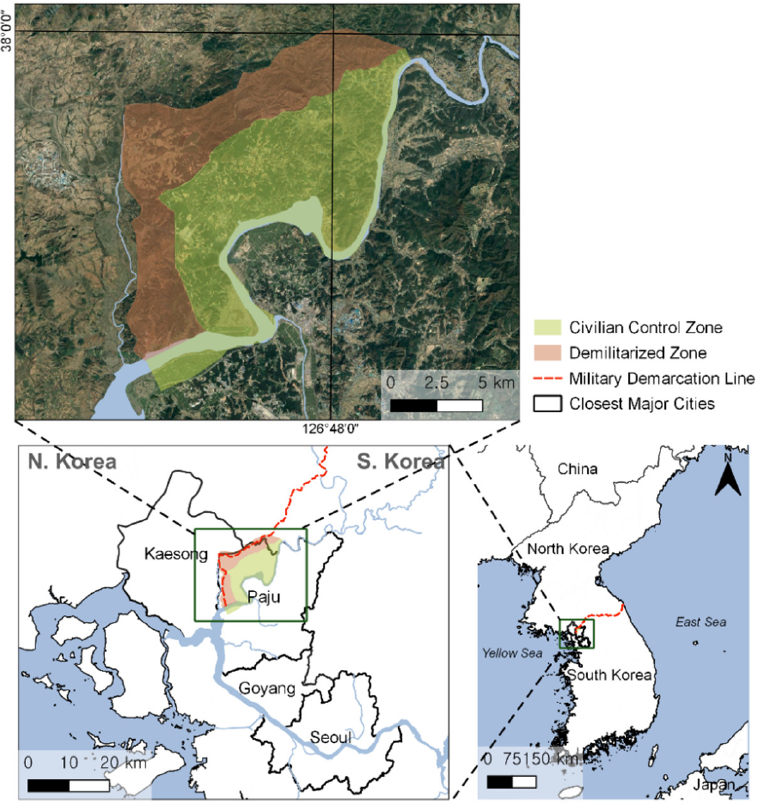
Figure 1. Location of study site in the Demilitarized Zone (DMZ) and Civilian Control Zone (CCZ) of Korea. Red- and yellow-green regions indicate the study site, including Paju-si city and Yeoncheon-gun county. The study site is surrounded by large cities of North and South Korea, such as Seoul, Goyang, Paju, and Kaesong.